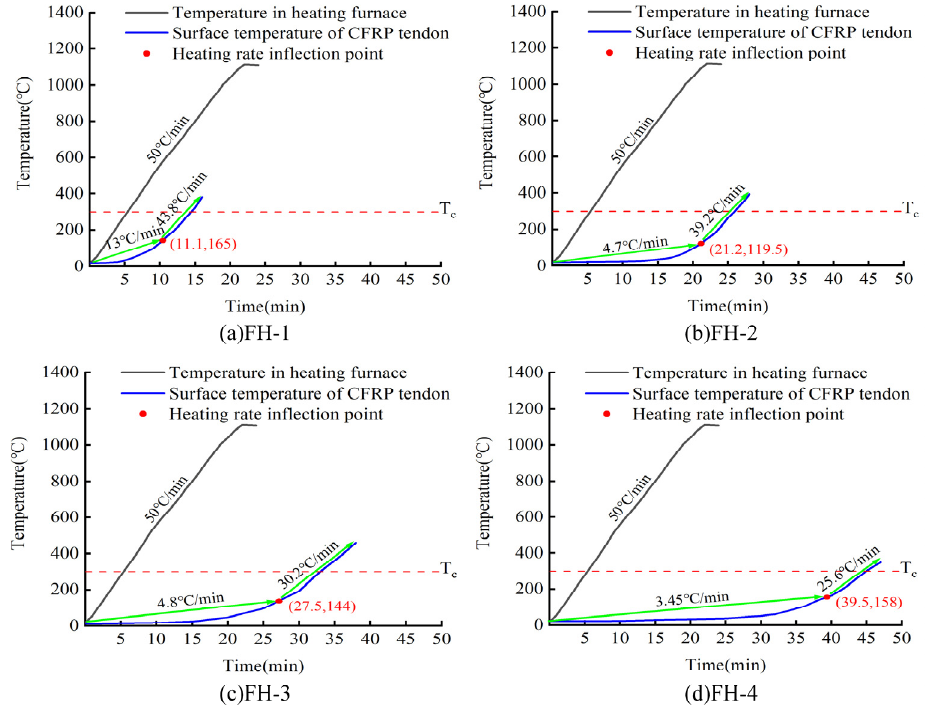
Figure 11. Heating curve of the surface of CFRP tendons wrapped with high-silica needled felt of different thicknesses.